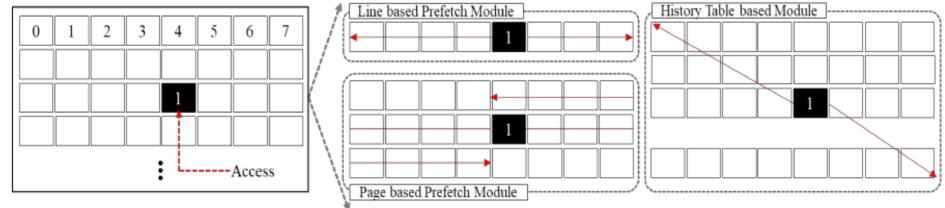
Figure 4. Selection criteria for the prefetching